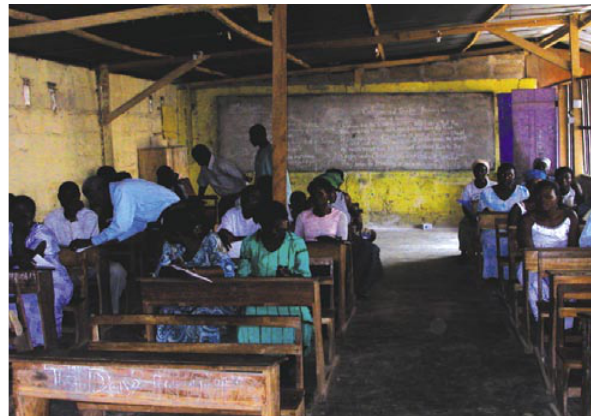
Figure 5. A typical classroom in Central Accra Region where learners attend evening